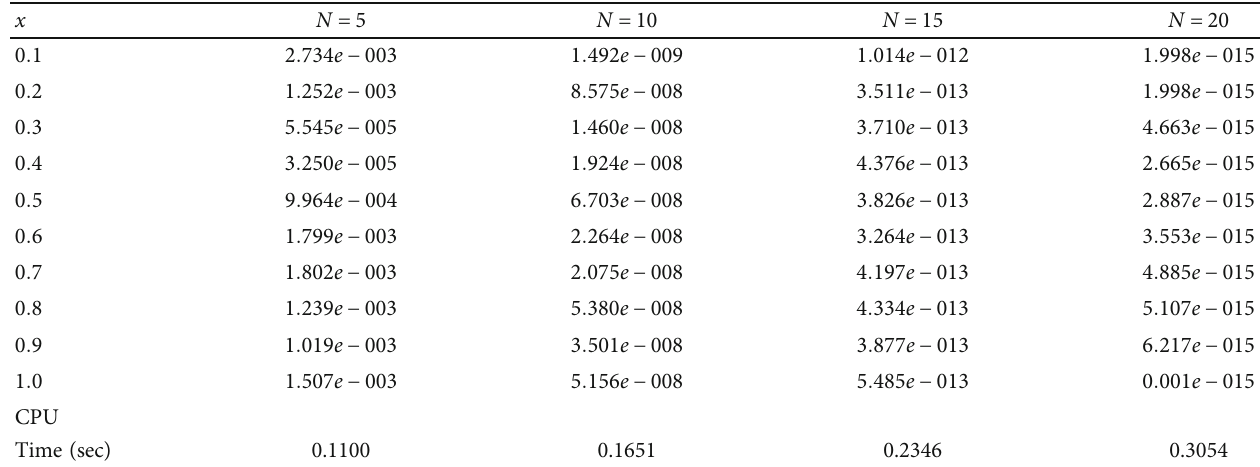
Table 5: Maximum absolute errors of Example 3 for di ff erent values of x and N